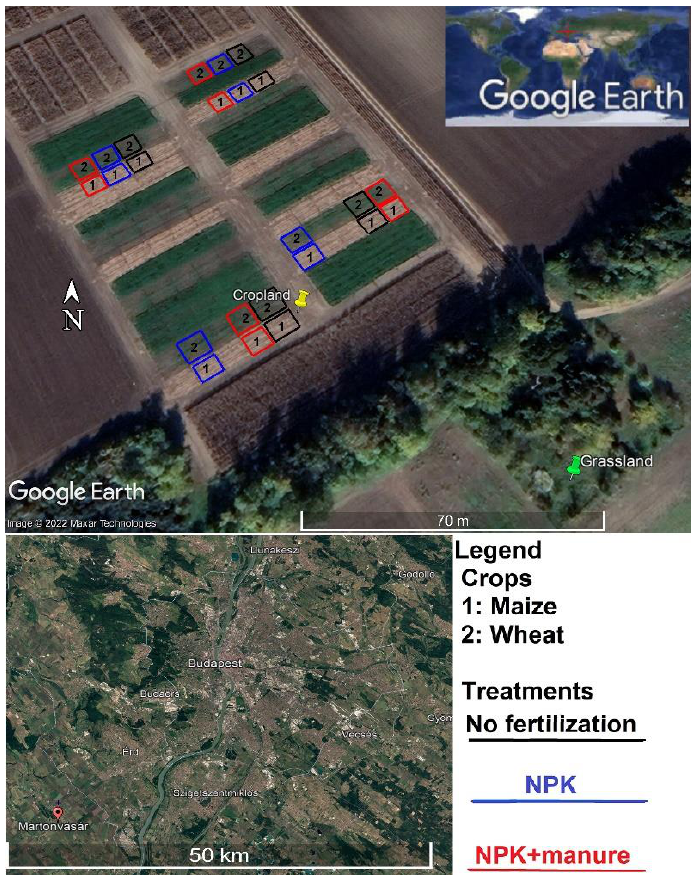
Figure 1. Location of the long-term field trial in Martonvásár, Hungary (Google Earth Pro).